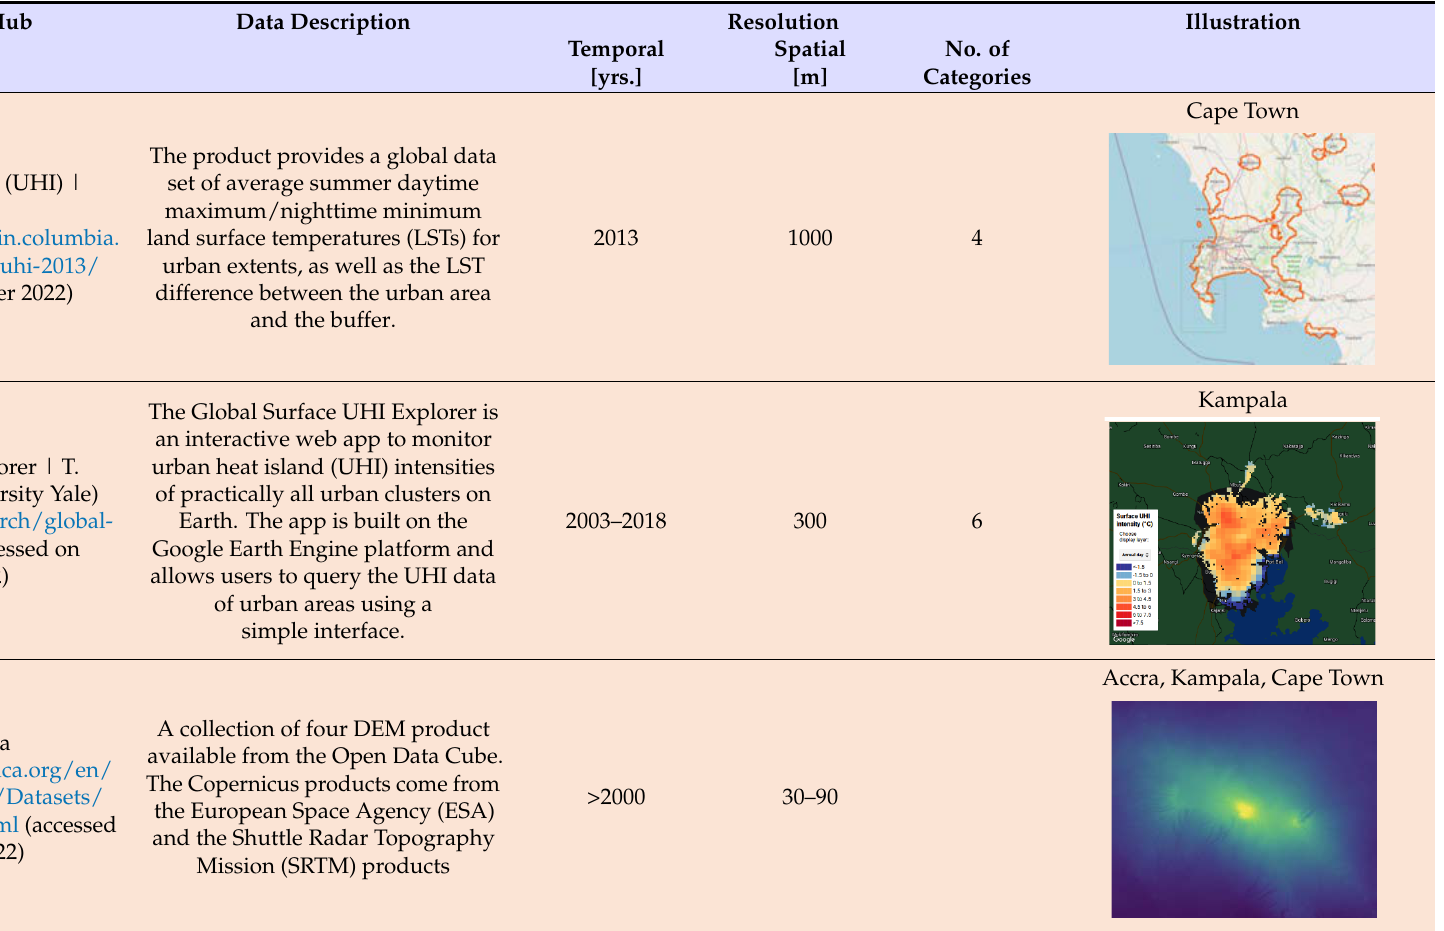
Table 3. EO dataset revealing optional dataset for exploring environmental pressures.